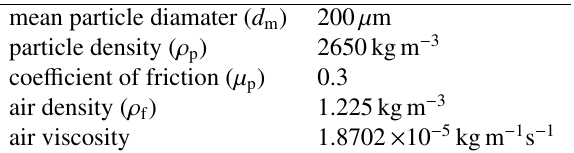
Figure 1. Snapshot of the simulation of a granular-bed collision process. Particle diameter d is uniformly distributed within the range 160 ≤ d /µ m ≤ 240. Table 1. Parameters of the